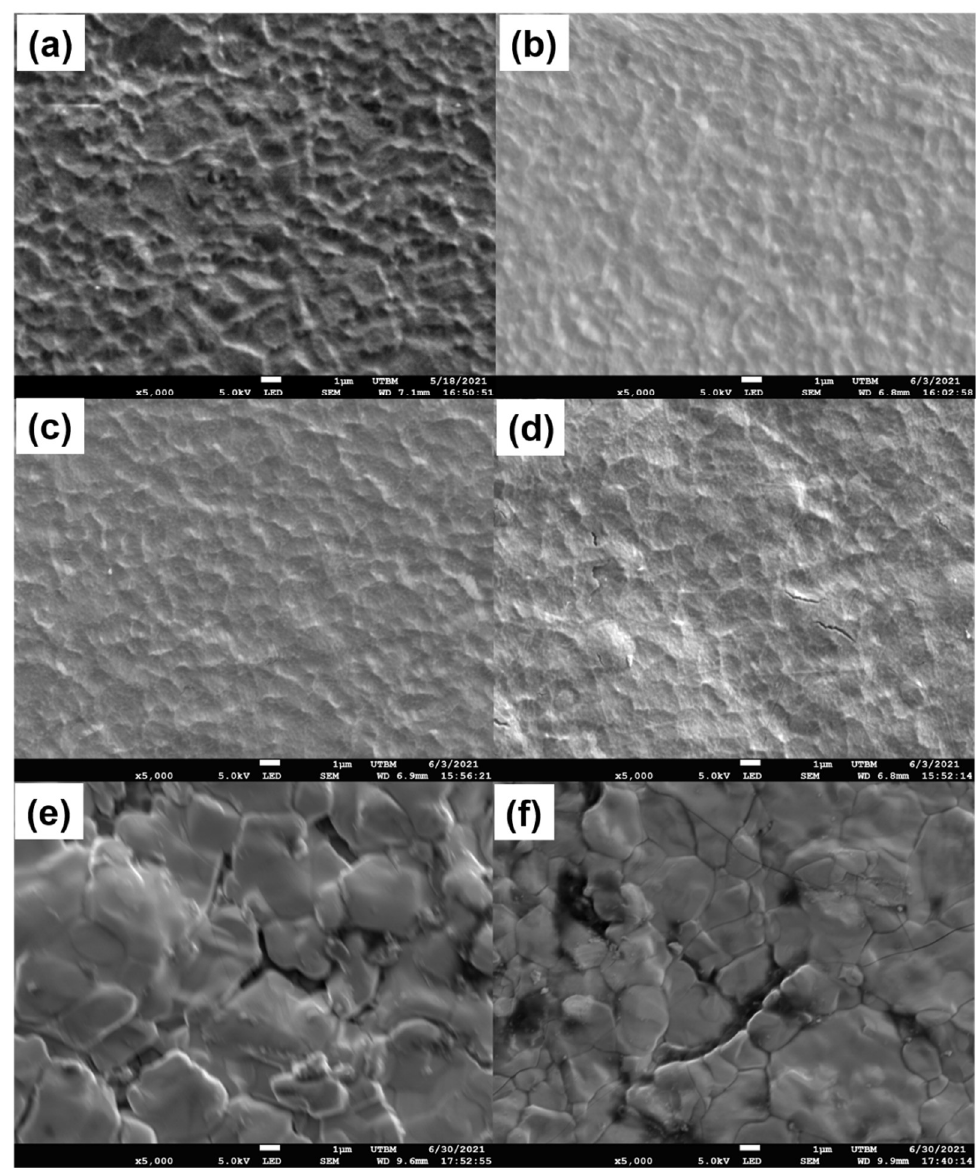
Figure 7. FESEM characterization of the top surface of the Bi 1.5 Y 0.5 O 3 films deposited on alumina plate varies with the different annealing temperature of ( a ) as deposited, ( b ) 400 °C, ( c ) 500 °C, ( d ) 600 °C, ( e ) 700 °C, ( f ) 800 °C.